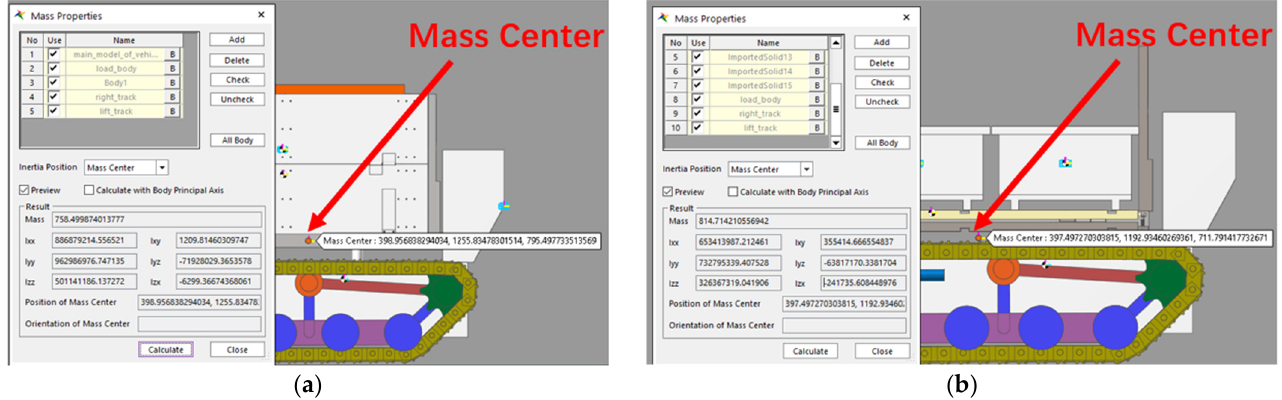
Figure 15. Position of center of gravity: ( a ) loading box fully loaded with bee frames and ( b ) loading box fully loaded with beehives.